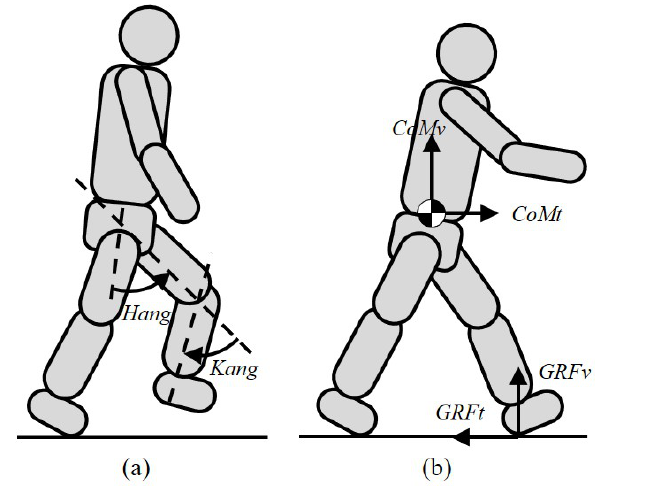
Figure 3. Definition of parameters: ( a ) Joint angles. ( b ) Kinematic parameters.